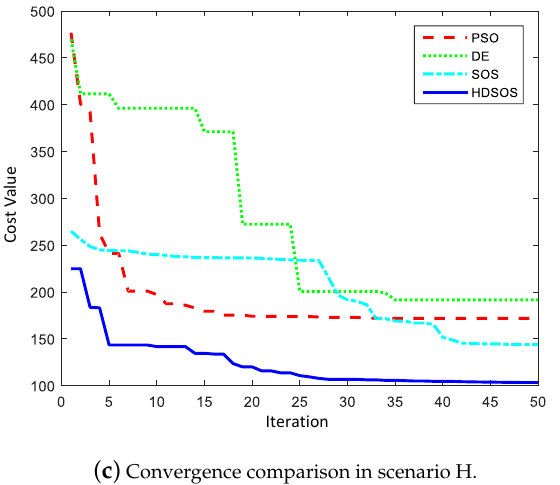
Figure 13. The comparative results for three-dimensional scenario